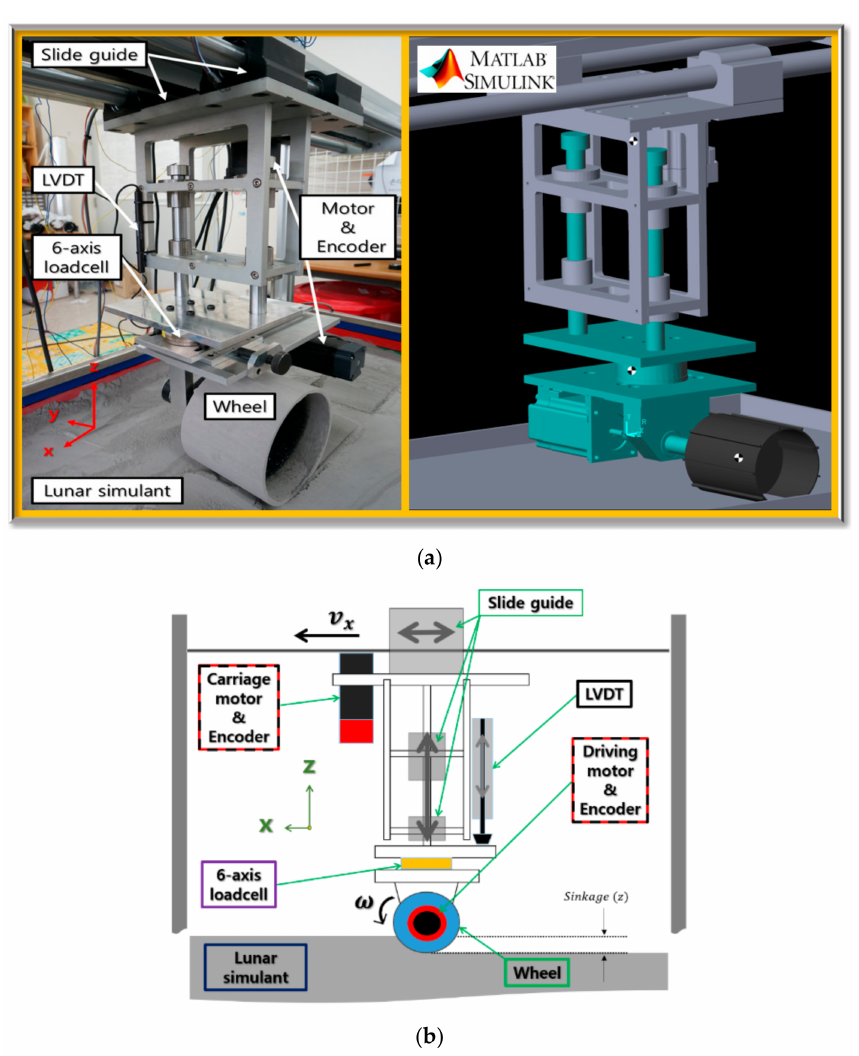
Figure 18. JBNU rover wheel testbed: ( a ) detailed view and simulation environment; ( b ) schematic